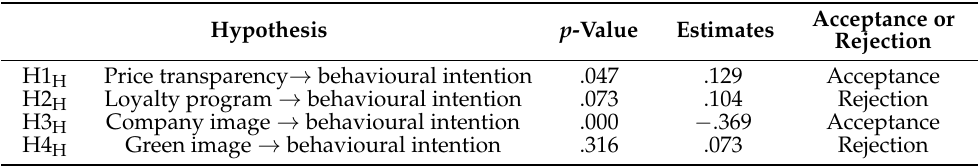
Table 6. Verification of research hypotheses (H